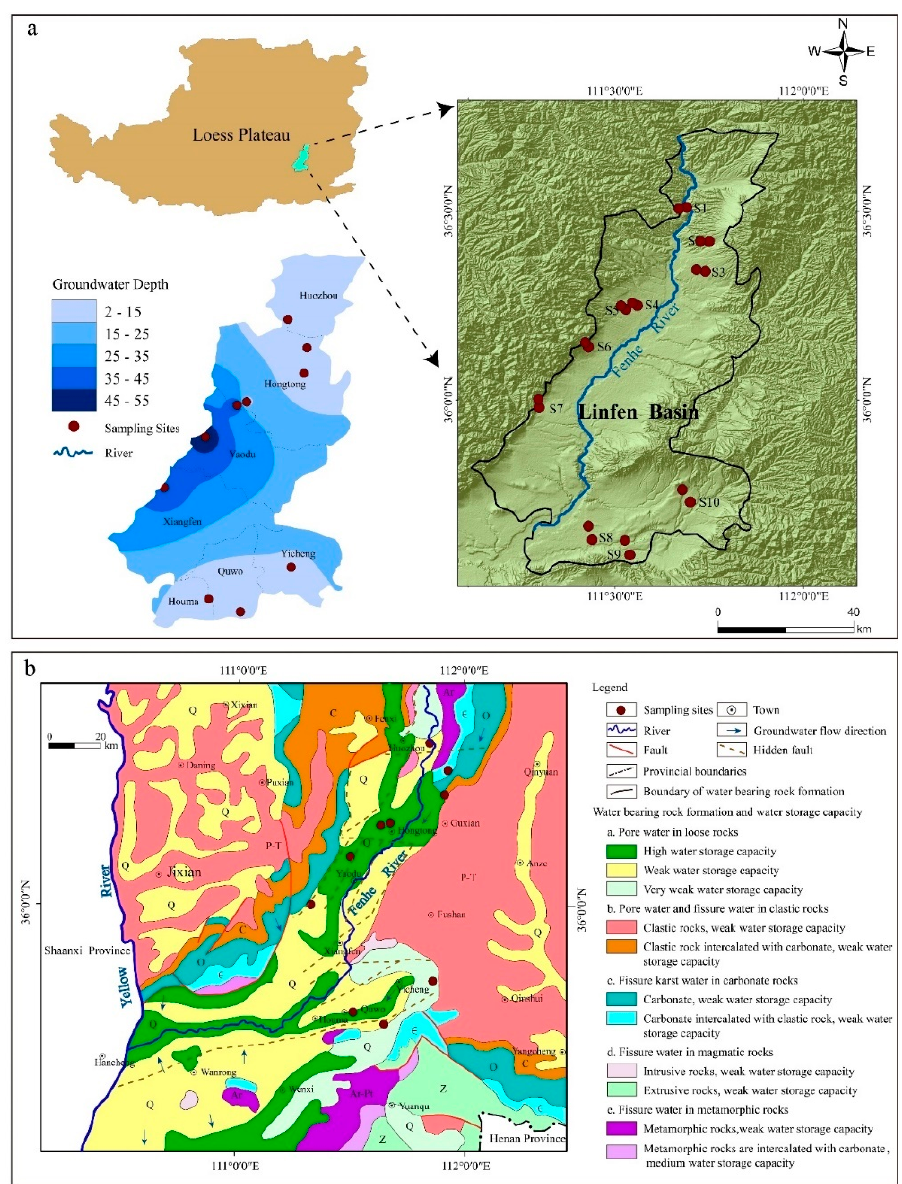
Figure 1. ( a ) Spatial distribution of groundwater sampling sites and groundwater depths and ( b ) Regional hydrogeological map of the study area.